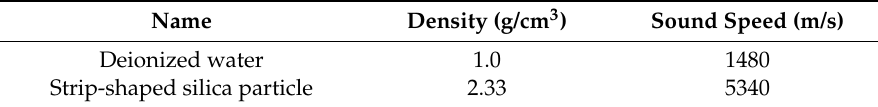
Table 1. Acoustic parameters of deionized water and silica bead.